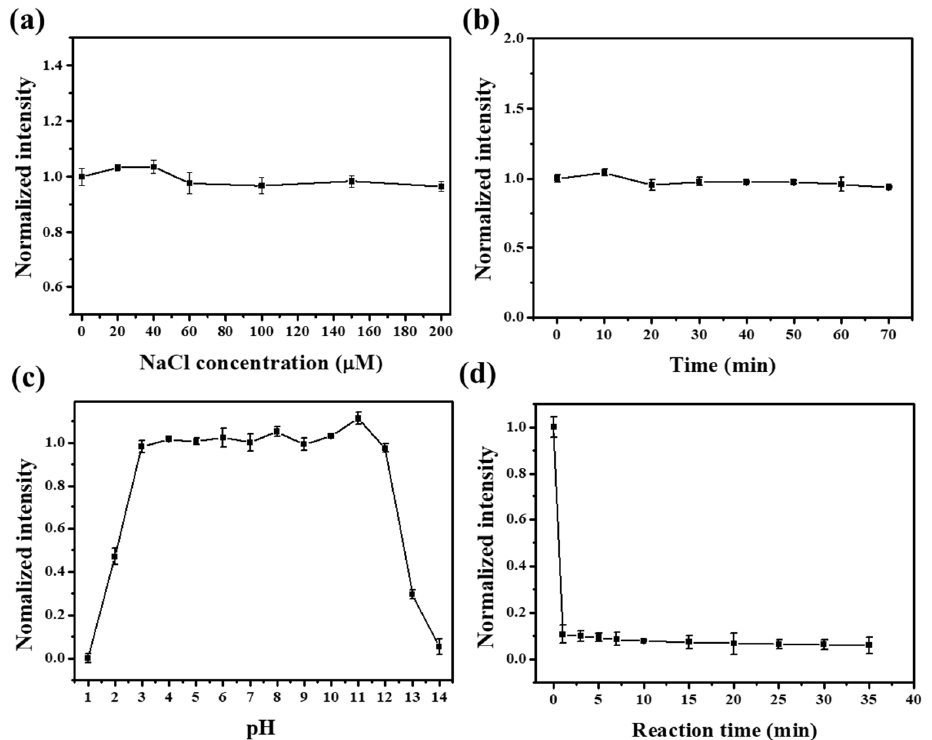
Figure 4. ( a ) The fluorescence intensity as a function of the NaCl concentration, ( b ) light exposure time, ( c ) pH of the solution, and ( d ) reaction time after adding 1 mM Fe 3+ . The selectivity of NFCDs against different ions was examined by measuring the flu-